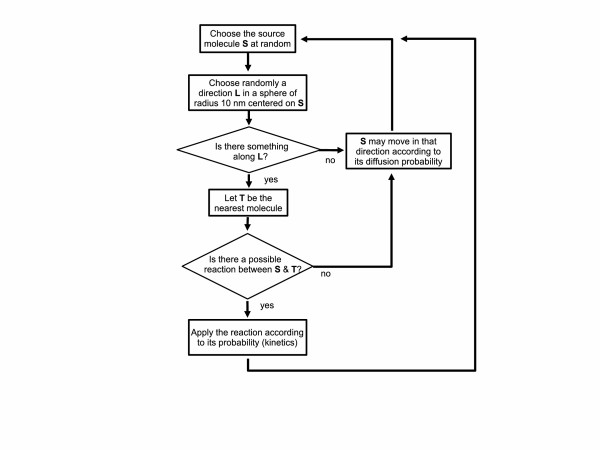
Overview of HSIM.